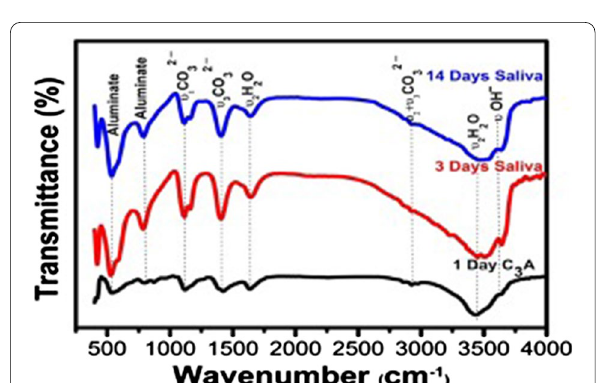
Fig. 5 FTIR spectra of the C 3 A composite samples cured under artificial saliva solution for 1, 3 and 14